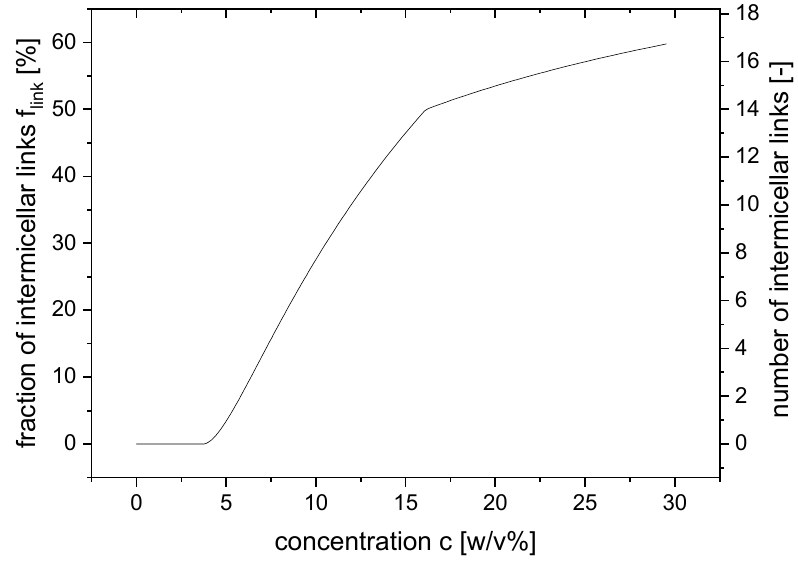
Figure 4. Average fraction and number of intermicellar links as a function of concentration.